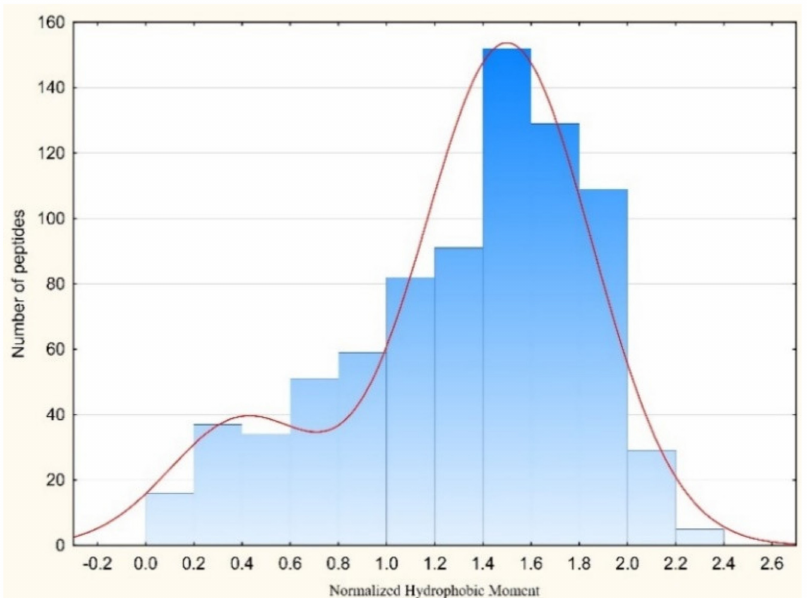
Figure 9. Distribution of the normalized hydrophobic moment ( µ ) of short (8–23 aa), linear, ribo- somal AMPs using the tools of the page of “Statistics” (https://dbaasp.org/statistics, accessed on